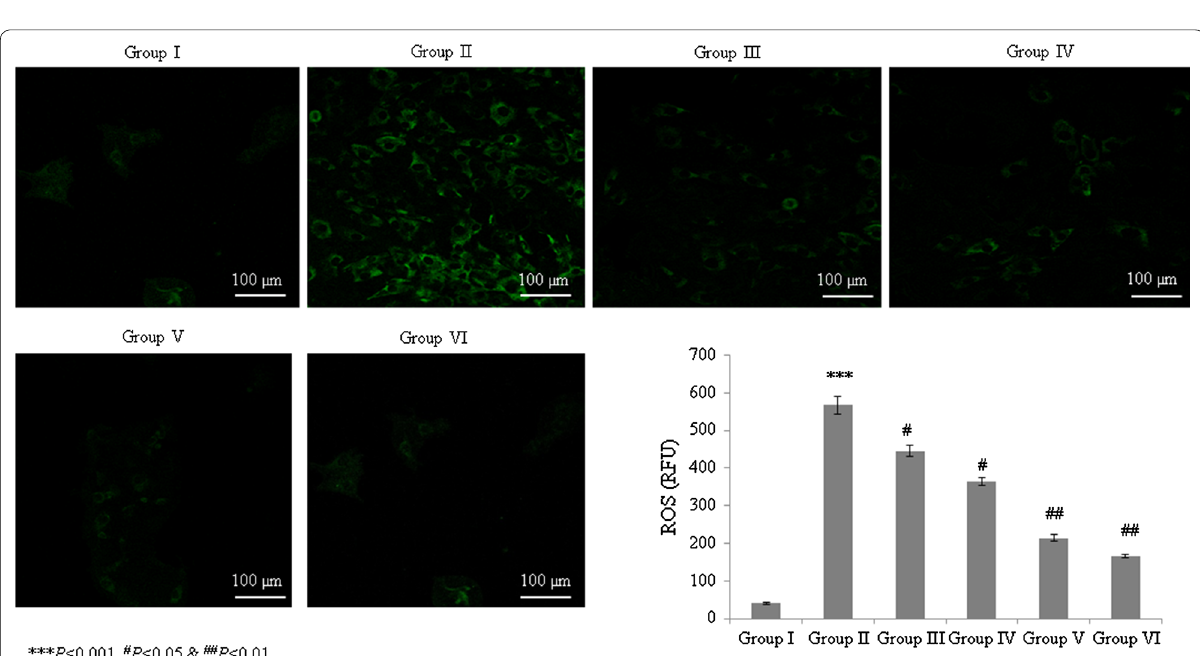
Fig. 3 a Microscopy images and b representative reactive oxygen species (ROS) levels after erythropoietin and sesame oil treatment in rats with ischemic kidney injury after kidney transplantation. *** P < 0.001 vs. sham rats; # P < 0.05 and ## P < 0.01 vs. control